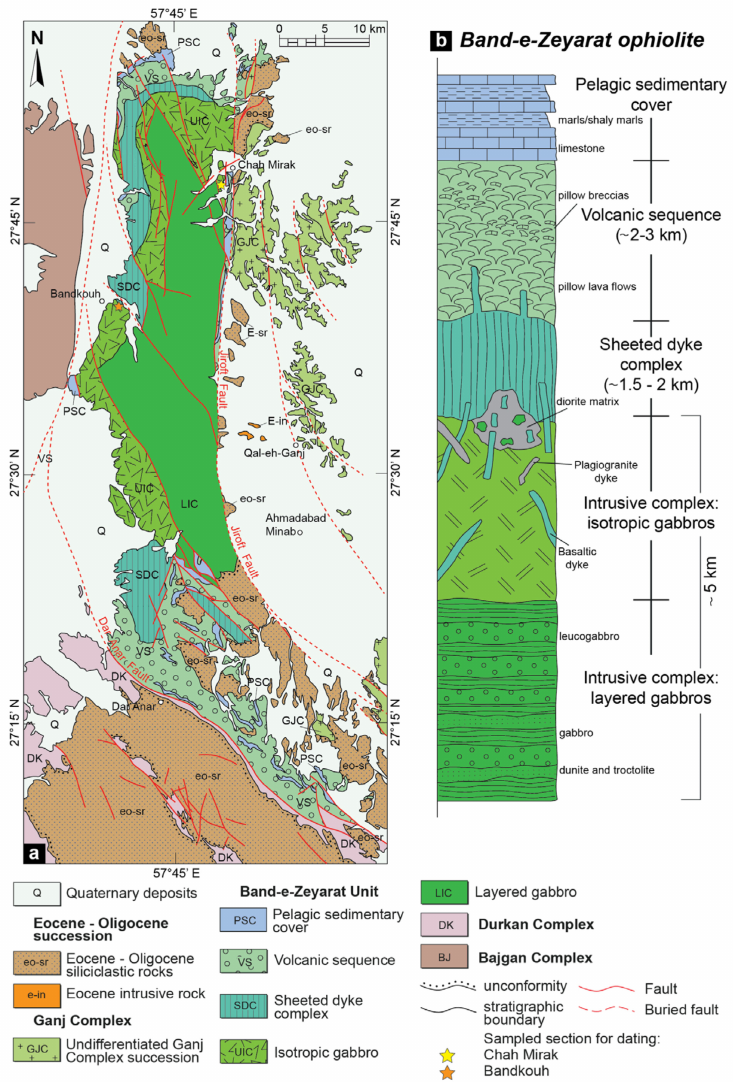
Figure 2. ( a ) Simplified geological map of north-western sector of the North Makran domain showing the structural setting of the Band-e-Zeyarat ophiolite (based on Samimi Namin [37] and modified according to our original fieldwork and photointerpretation with satellite images). ( b ) Schematic stratigraphic column of the Band-e-Zeyarat